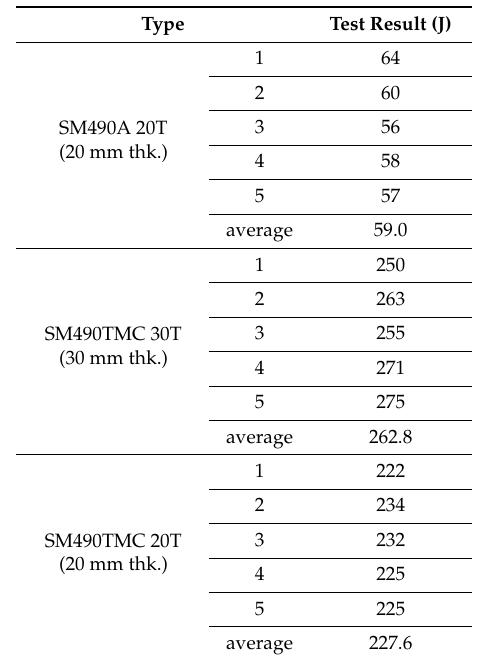
Table 3. Charpy impact test